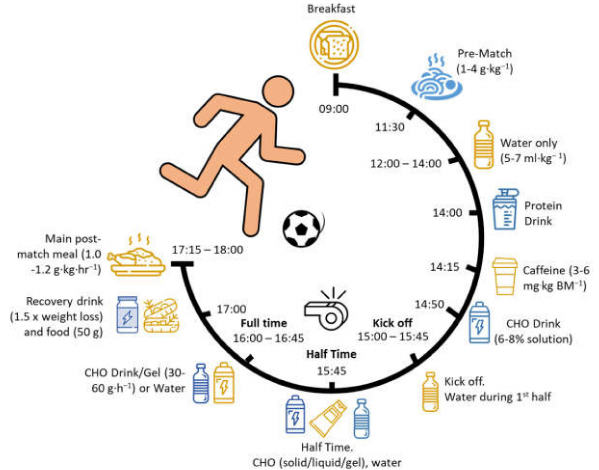
Figure 2. Schematic of a typical nutrition scenario for a player undertaking a soccer match starting at 15:00 (requirements based on